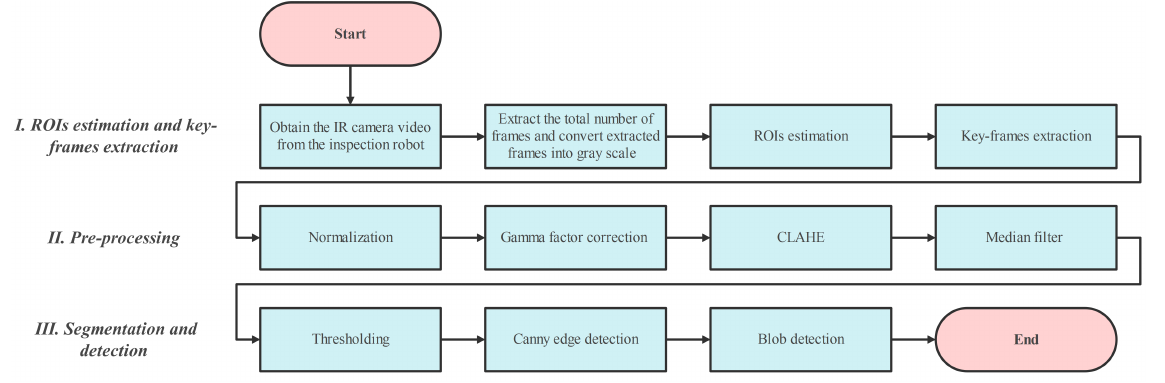
Figure 2. Simplified flowcharts of proposed